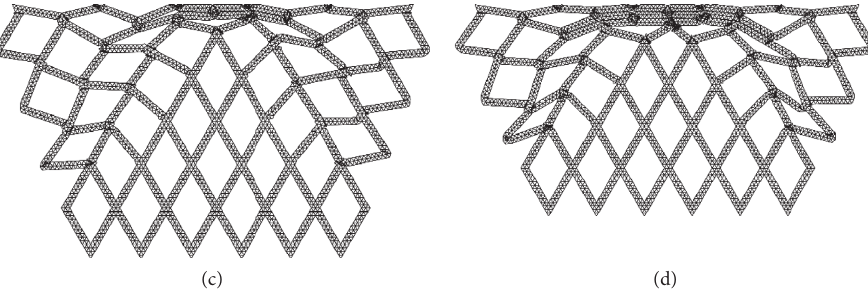
Figure 8: FE prediction of the quasi-static collapse of the DHH in the z direction. (a) ε � 10%. (b) ε � 20%. (c) ε � 30%. (d) ε � 40%.